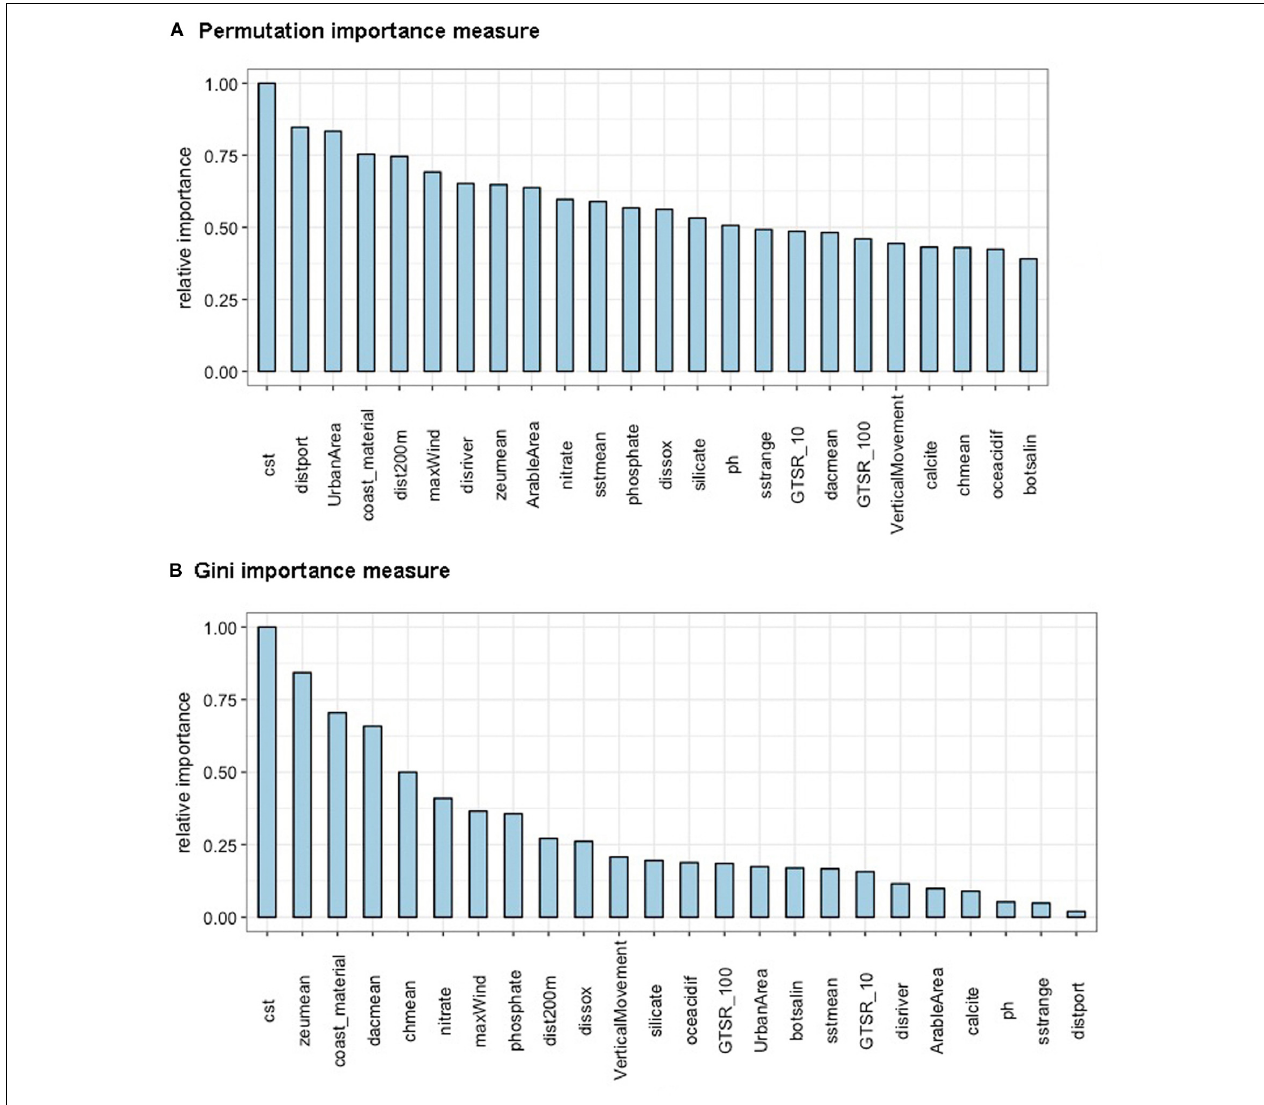
FIGURE 4 | Most relevant variables according to importance values obtained from both the permutation (A) and the Gini importance measures (B) . Name of the variables in alphabetical order: “ArableArea” = arable area (in km2); “botsalin” = bottom salinity; “calcite” = calcite concentration; “chmean” = chlorophyll a concentration (mean); “coast_material” = coast material classes; “cst” = topographic coastal slope (in degrees, 30 arc-seconds resolution); “dacmean” = diffuse attenuation coefficient; “disriver” = distance to river mouths; “dissox” = dissolved oxygen concentration; “dist200 m” = distance to 200 m isobath; “distport” = distance to ports; “GTSR_10” = height above mean sea level in 10 years (in m); “GTSR_100” = height above mean sea level in 100 years (in m); “maxWind” = max stress of wind from 2008 to 2017 (in Pa); “nitrate” = nitrate concentration; “oceacidif” = ocean acidification; “ph” = pH; “phosphate” = phosphate concentration; “silicate” = silicate concentration; “sstmean” = sea surface temperature (mean); “sstrange” = sea surface temperature (annual range); “UrbanArea” = urban area (in km2); “VerticalMovement” = vertical land movement (in mm/yr); “zeumean” = euphotic